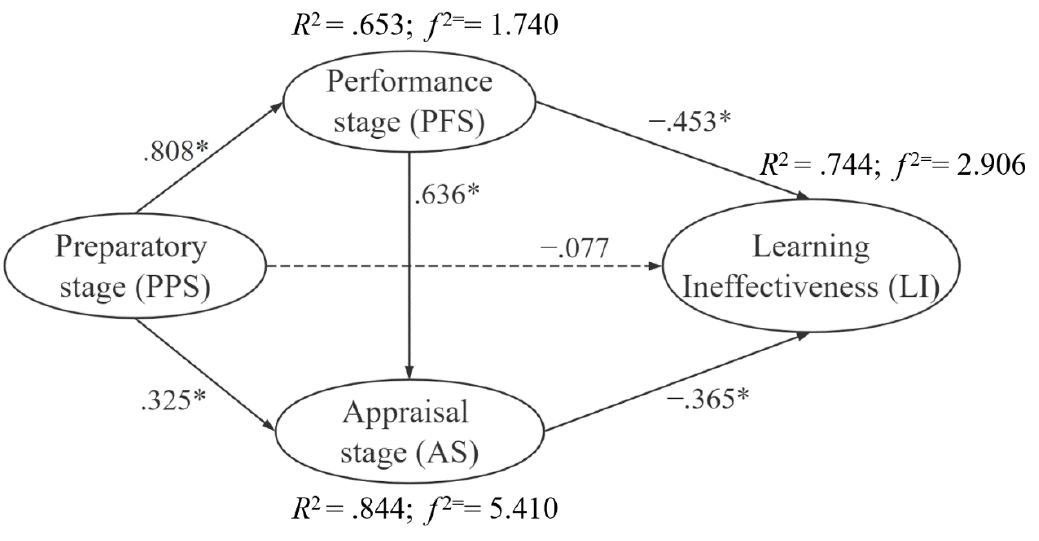
The Structural Model w ith Standardized